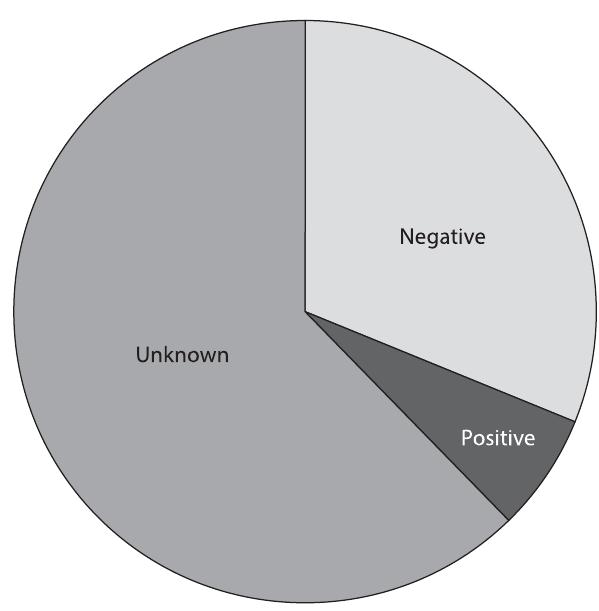
Figure 3: HIV status during admission.